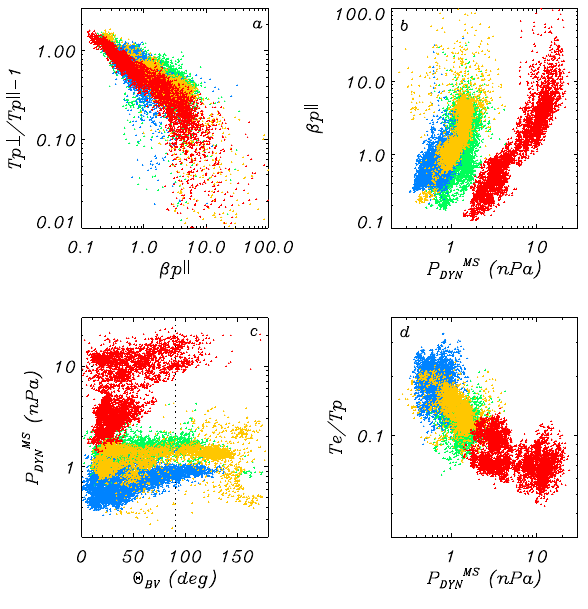
Figure2:Onthedays12/02/2001(00:15to07:30UT,greenpoints),16/12/2001